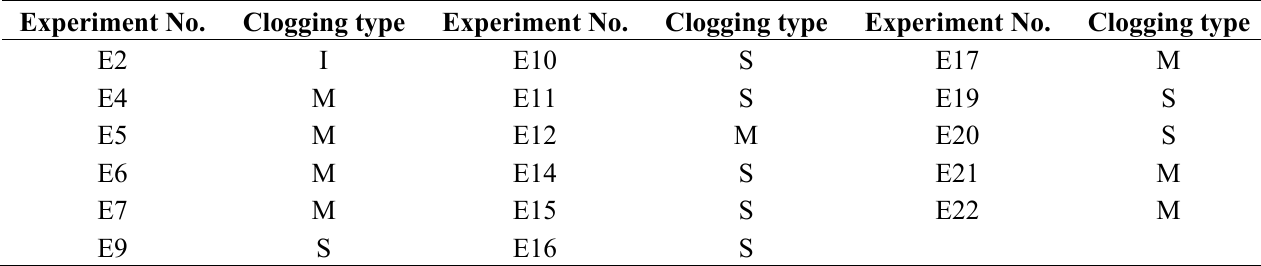
Table 3. Suspended solids clogging types in laboratory